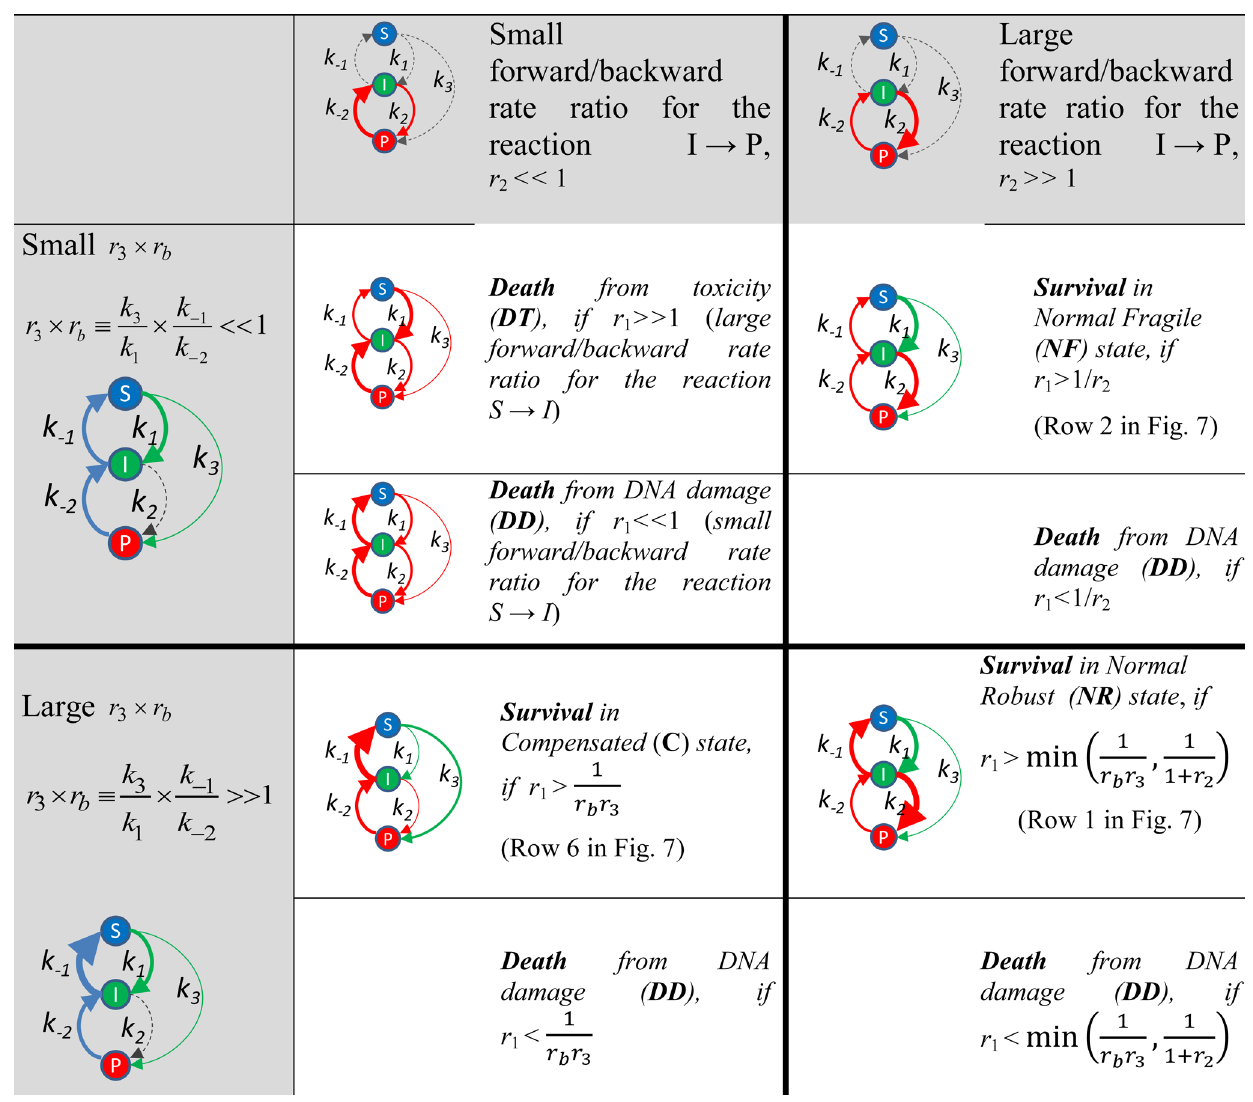
Figure 4. Pathway steady states for various combinations of parameters in the mathematical model of DNA repair with reversible steps and a toxic intermediate. The classification of pathway steady states depends on the values of three control parameters, representing the ratios of some kinetic rates of the model (for more details see Section S2A in Text S1): The diagrams visualize the values of the control parameters where thickness of the solid arrows shows the relative value of the corresponding kinetic rate and the dashed arrows represent kinetic rates which values are irrelevant for a given scenario. Color coding shows partial orderings of the parameters important for a given pathway state (thickness of edges of the same color should be compared but not between color.